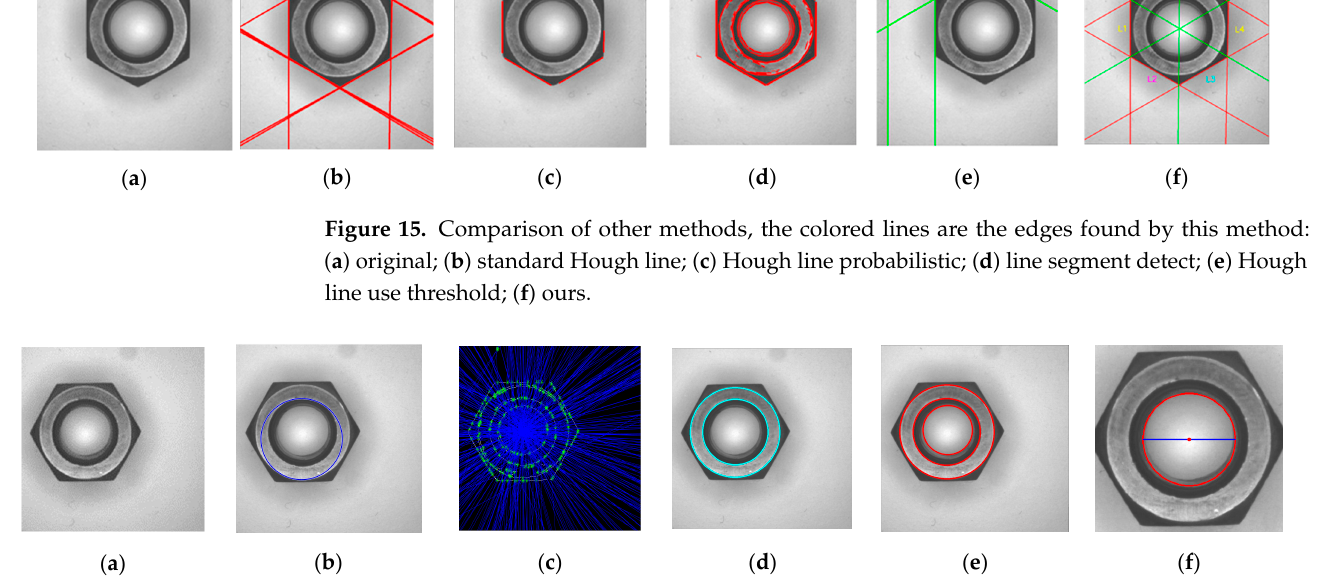
Figure 16. Comparison of other methods, the colored lines are the circle found by this method: ( a ) original; ( b ) standard Hough circle; ( c ) random circle detection; ( d ) Ransac circle; ( e ) Taubin; ( f ) ours. The preset quali fi cation of the proposed method is within ±1% of the standard. This method can be used to determine whether to replace the tap when the number of unac- ceptable nuts exceeds a certain limit. The before-tapping mean di ff erence (BMD), before- were calculated. The after-tapping mean di ff erence (AMD), before-tapping mean (BM), lated.